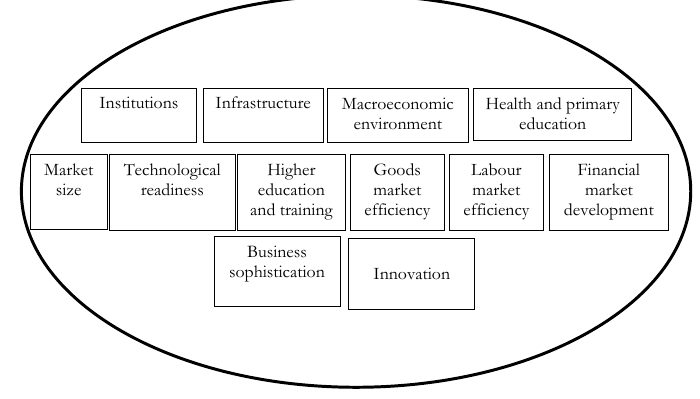
Fig. 2 – Pillars of GCI index. Source: The Global Competitiveness Report 2018. (2018).